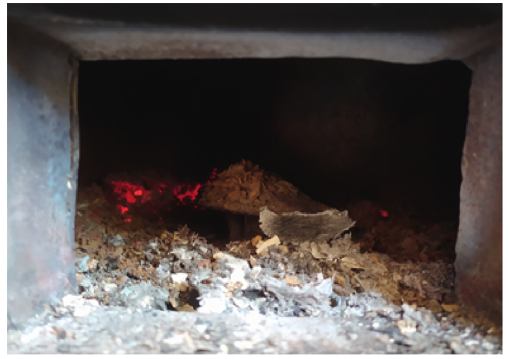
Figure 8: Residual ashes’ burning.